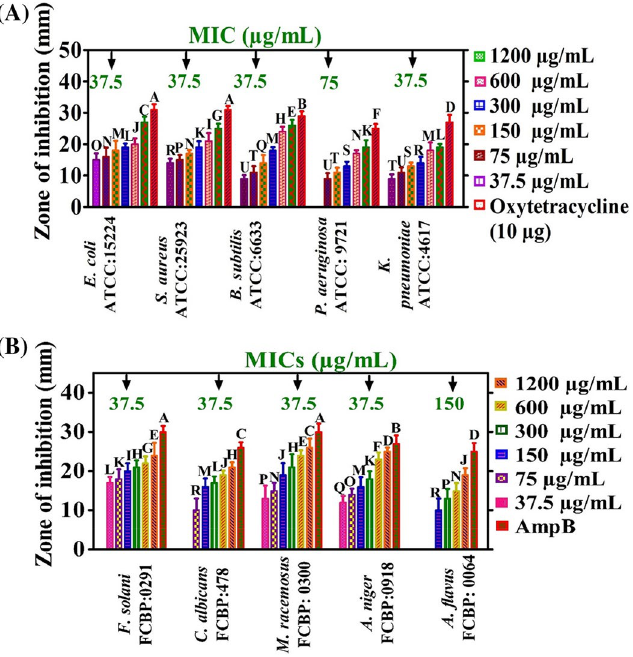
Figure 6. Antimicrobial activities of ZnONPs with MICs values. Data represents the mean of three replicates and each letter indicates significance at P < 0.05. There are 22 groups (A, B, etc.) in which the means are not significantly different from one another. Data represents the mean of three replicates ( a ) bactericidal activities; ( b ) fungicidal